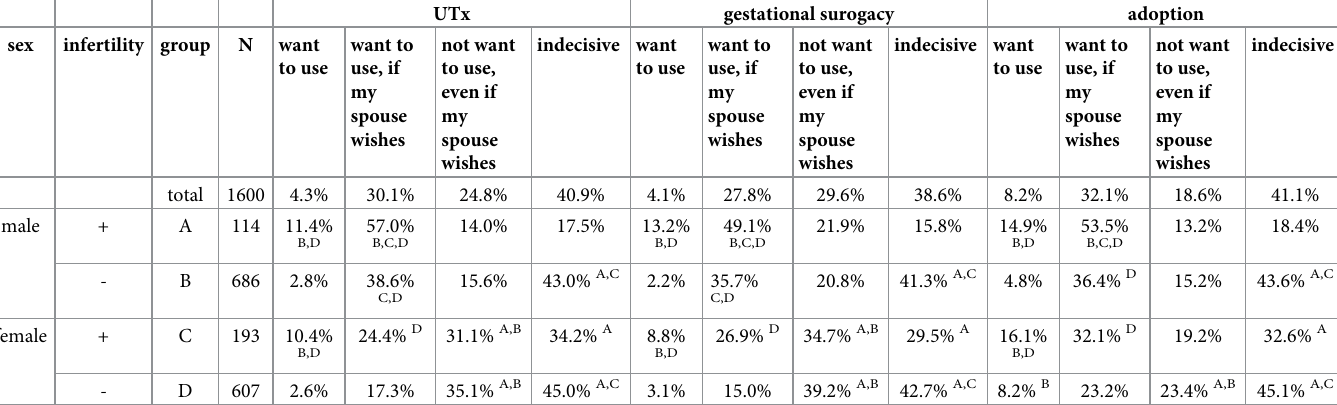
Table 8. Attitudes towards UTx, gestational surrogacy, and adoption, assuming that the respondents or their spouses are suffering from absolute uterine factor